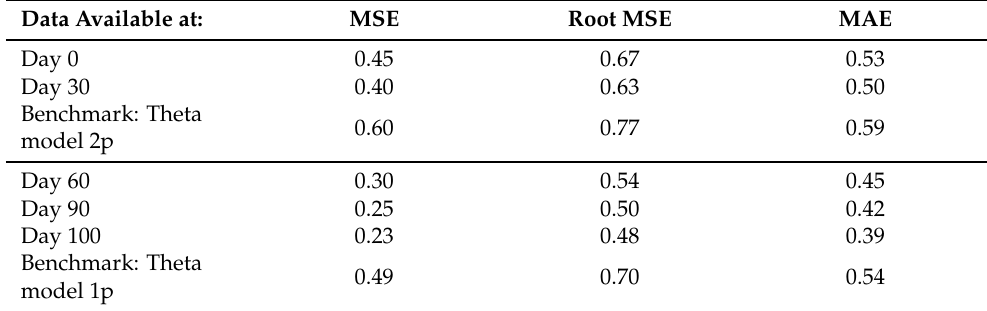
Table A2. Mean squared and absolute out-of-sample forecast errors of the median of Models (1) to (6) conditioned with available data over the current quarter (full sample 2002Q1–2019Q4).